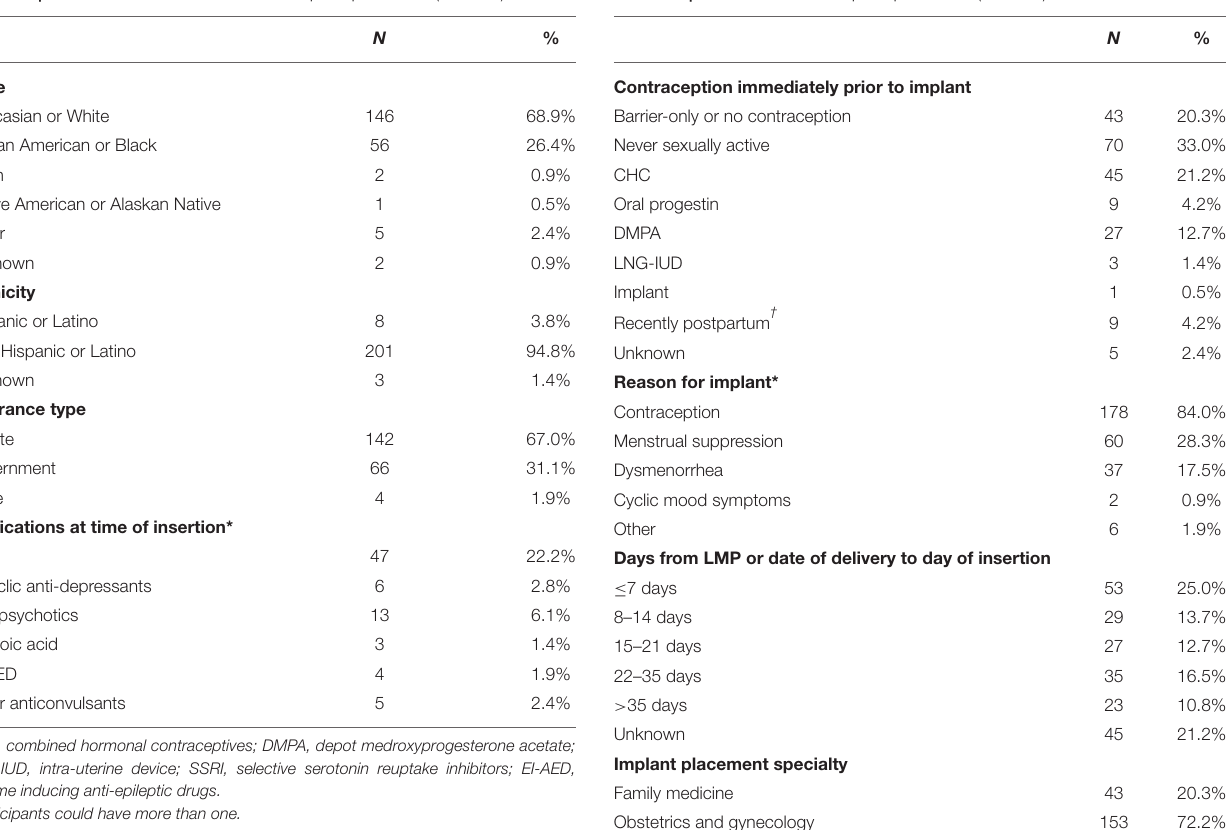
TABLE 1 | Patient characteristics at time of implant placement ( n = 212). TABLE 2 | Factors at time of implant placement ( n =